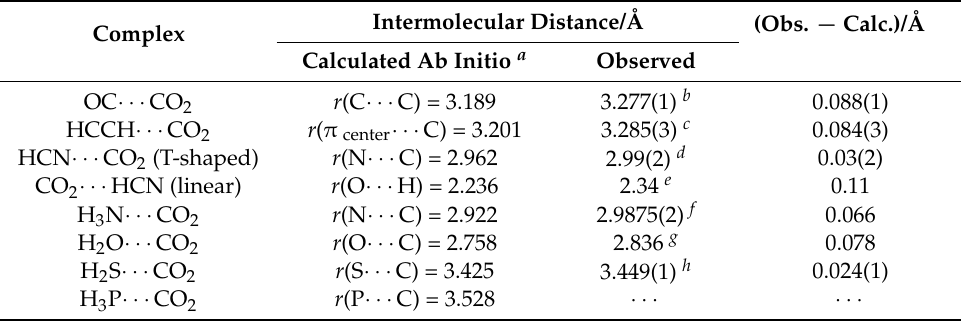
Table 1. Calculated and observed intermolecular distances in B · · · CO 2 complexes. Intermolecular Distance/Å (Obs. − Calc.)/Å Complex Calculated Ab Initio a Observed